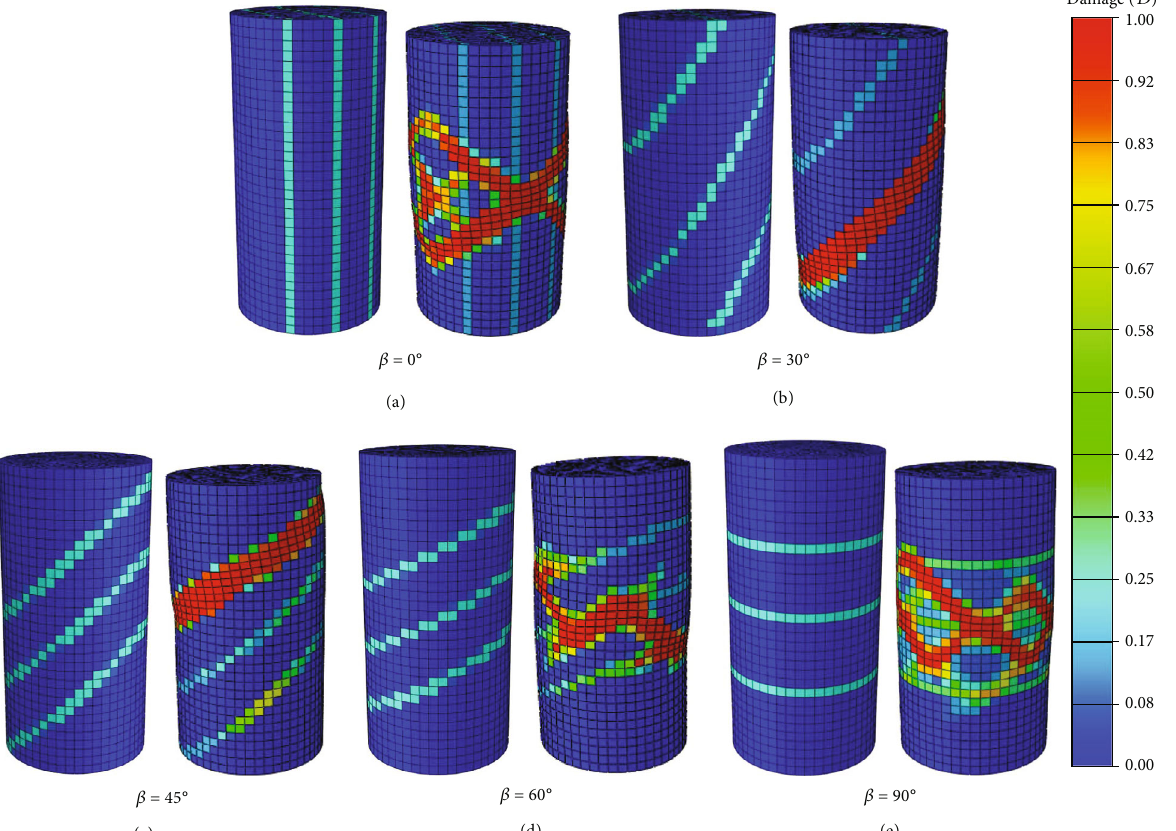
Figure 15: Simulations of damage distributions of cores under di ff erent bedding orientations.